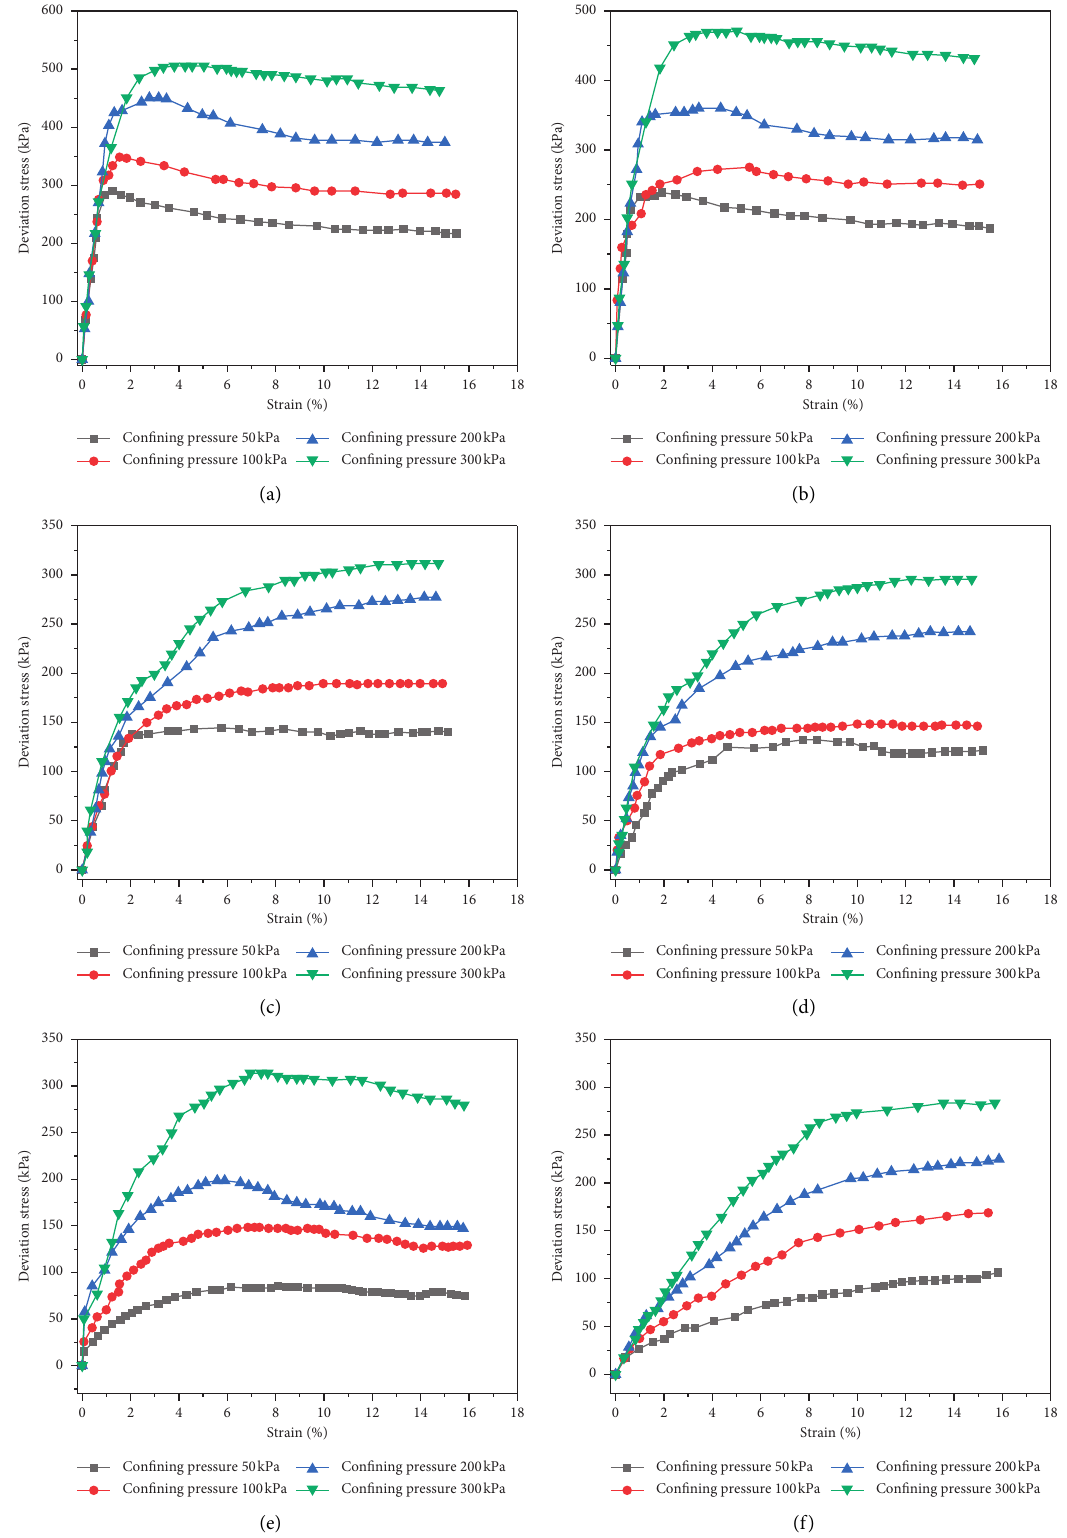
Figure 7: Stress-strain curves of the samples with an initial water content of w � 20% for different numbers of cycles. Moisture content w � 20% for (a) zero cycles, (b) one cycle, (c) two cycles, (d) three cycles, (e) four cycles, and (f) five